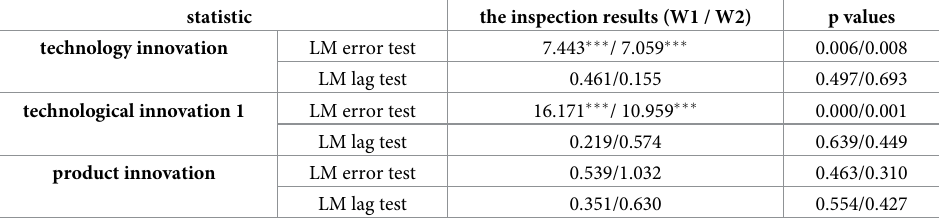
Table 3. LM test results of each variable.